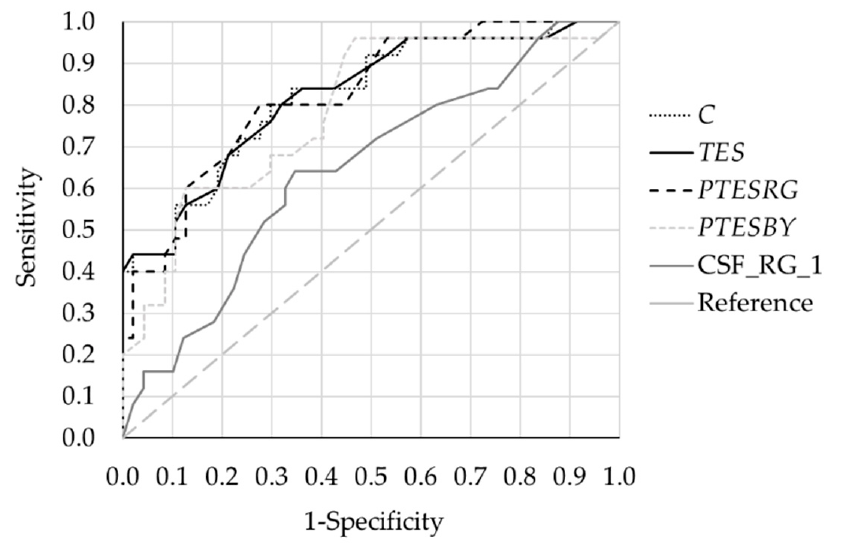
Figure 7. ROC curves for different parameters: FM100h scores ( TES , PTESRG , PTESBY , computed principal component C ), and 1 cpd contrast sensitivity for the red-green mechanism (CSF_RG_1). AUC, area under curve; SENS, sensitivity; SPEC, specificity; CUT OFF , cutoff value of the curve.